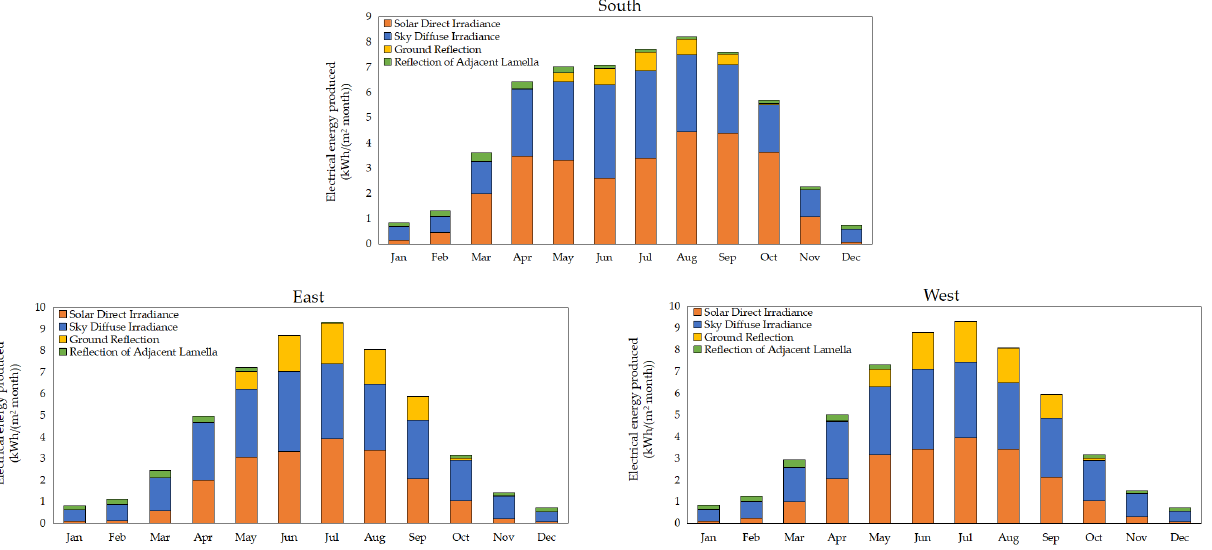
Figure 13. Contributions of electricity produced by SPBs per unit of vertical area (south, east and west orientations).